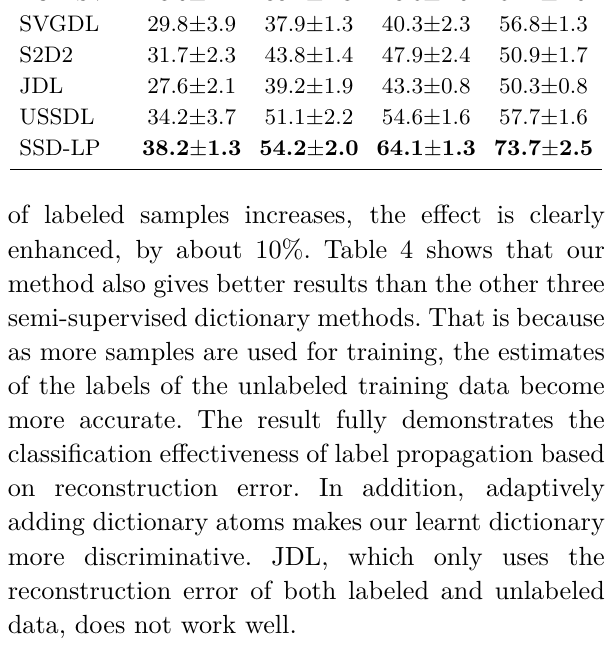
algorithm for designing overcomplete dictionaries